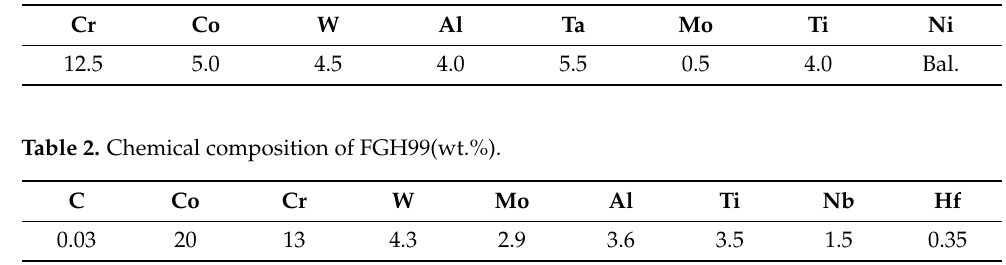
Table 1. Chemical composition of DD10(wt.%).